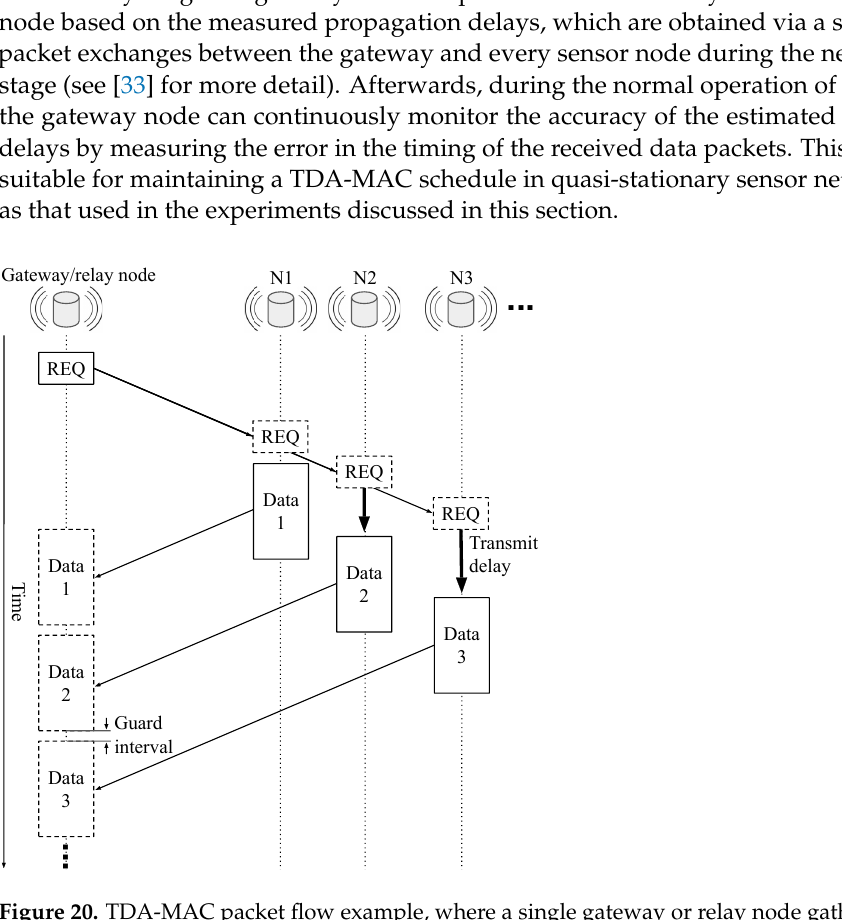
Figure 20. TDA-MAC packet flow example, where a single gateway or relay node gathers data from three directly connected sensor nodes